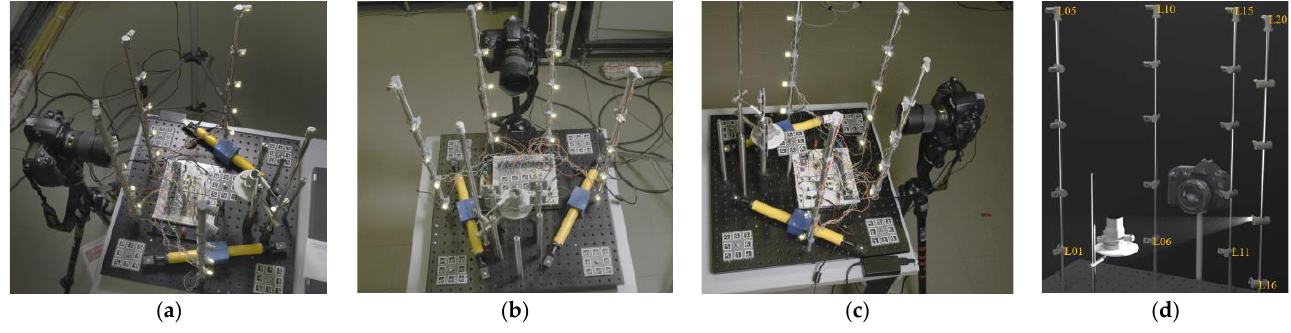
Figure 8. The proposed image acquisition system for combining photometric stereo and photogram- metry( a – c ). The configuration of the overall lighting system ( d ).